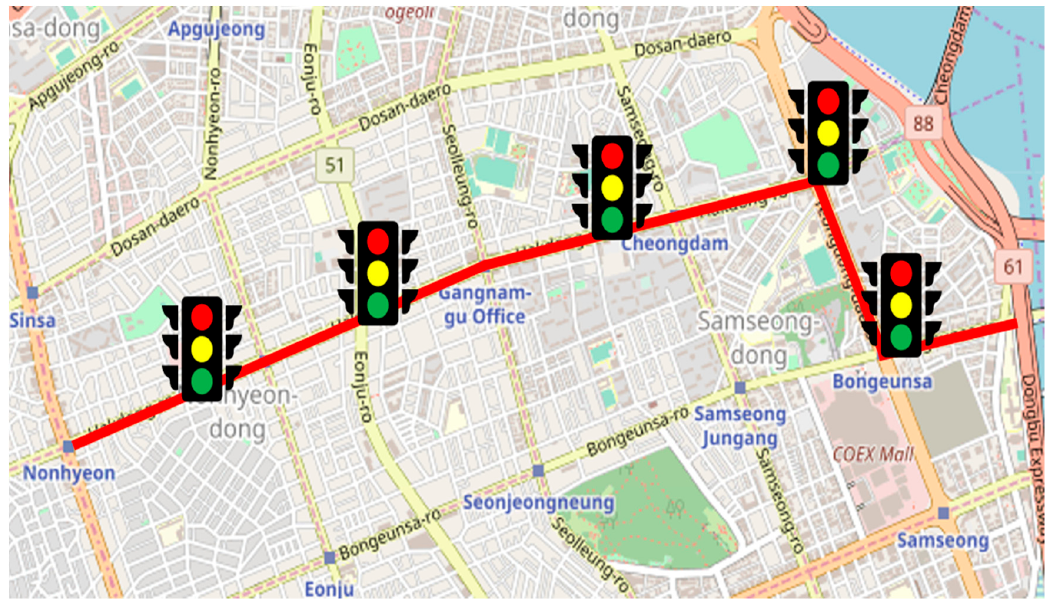
Figure 6. Driving route on map with traffic lights.